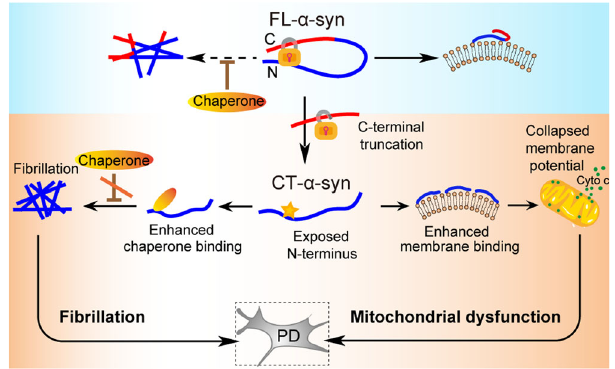
Fig. 5 Possible mechanism of CT- α -syn involvement in the pathogenesis of PD. The interaction between FL- α -syn and membranes is critical for neurotransmitter release, and fi brillation of FL- α -syn is inhibited by chaperones. When the C-terminus is truncated, the interaction with membranes and chaperones becomes stronger, leading to diminished inhibition of fi brillation and mitochondrial damage that is likely to elicit a truncation cycle contributing to